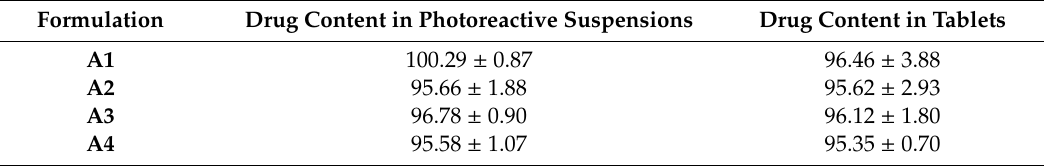
Table 3. Drug content in photopolymer suspensions and tablets (% ± S.D.).